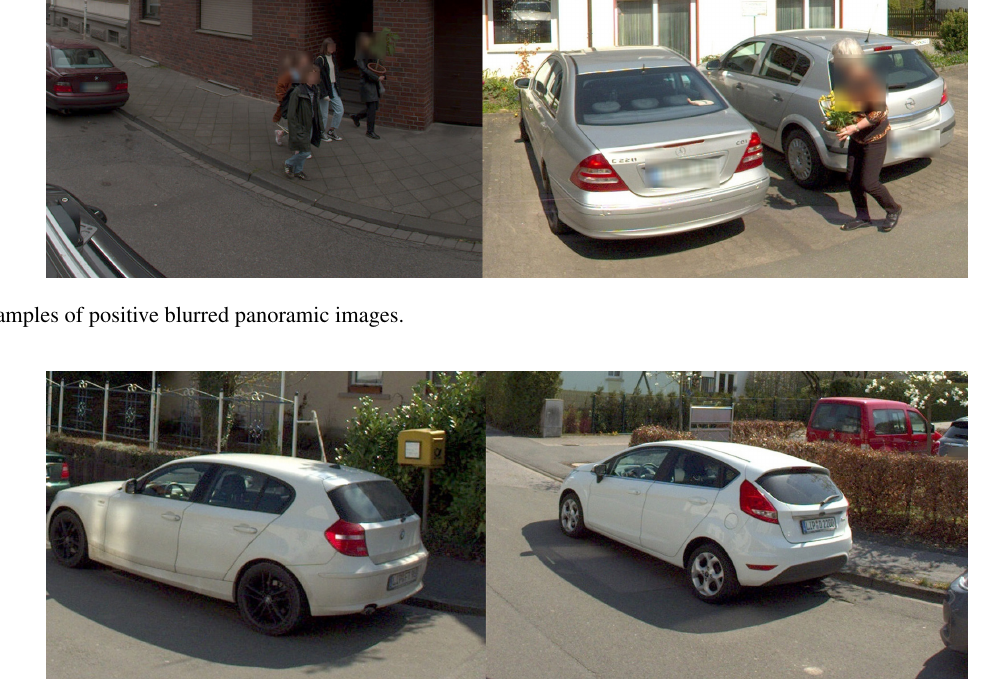
Figure 7. Examples of negative blurred panoramic